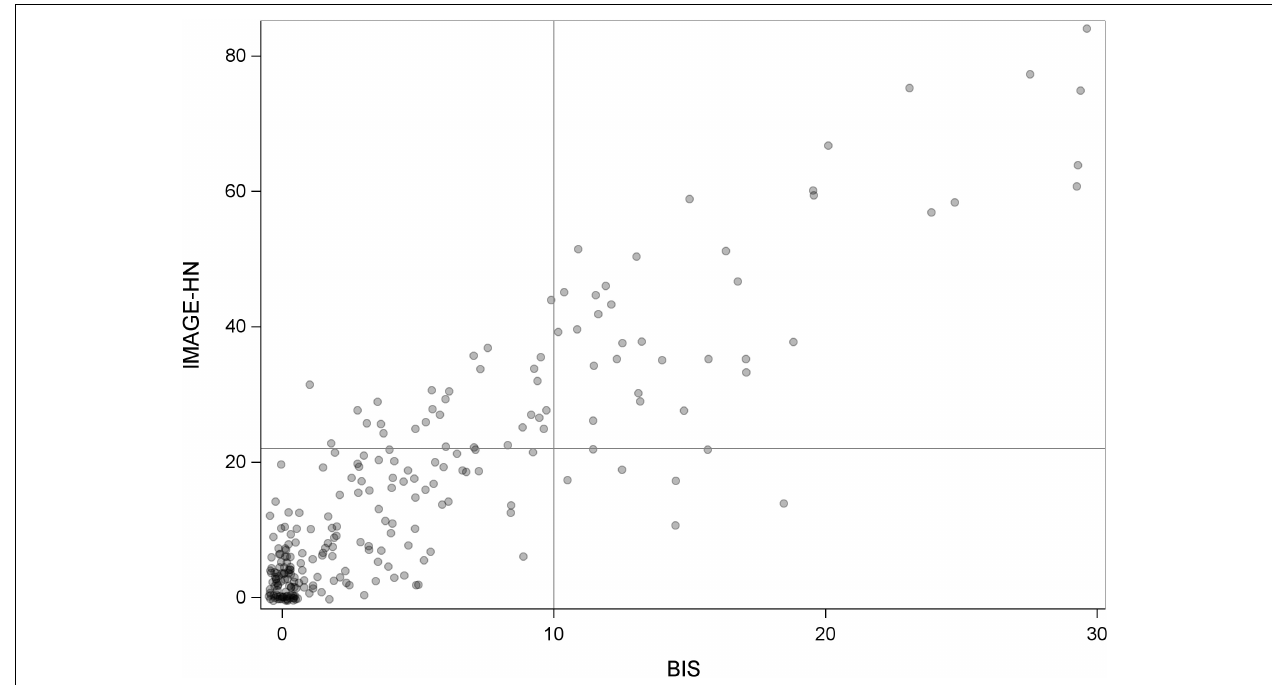
FIGURE 2 | IMAGE-HN vs. BIS scores. Scatterplot showing the distribution of IMAGE-HN and BIS scores for our study sample. Circles represent the IMAGE-HN and BIS scores of each patient, with a jitter (small amount of random noise) applied to minimize overlap of observations. Any remaining overlapping observations are indicated by darker shaded circles. Twenty-eight patients (11% of the cohort) have clinically relevant HNC-related BID as measured by IMAGE-HN score ≥ 22 who would not be identified using the BIS (BIS < 10; circles in the upper left quadrant). Forty-two patients (17% of the cohort) have clinically relevant HNC-related BID as measured by IMAGE-HN score ≥ 22 who would have been identified by the BIS (BIS > 10; circles in the right upper quadrant). One hundred seventy-five patients (70% of the cohort) do not have clinically relevant HNC-related BID as measured by IMAGE-HN score < 22, who also have BIS < 10 (bottom left quadrant). Five patients (2% of the cohort) would not be identified as having clinically relevant HNC-related BID as measured by an IMAGE-HN score < 22 who would have been identified using a BIS score > 10 (bottom right quadrant). TABLE 2 | Association of clinically relevant IMAGE-HN scores with depression, anxiety, and head and neck quality of life. Scale Full sample ( n = 250) IMAGE-HN < 22 ( n = 180) IMAGE-HN ≥ 22 ( n = 70) p -value Mean SD Mean SD Mean SD IMAGE-HN 1 Global (raw sum)